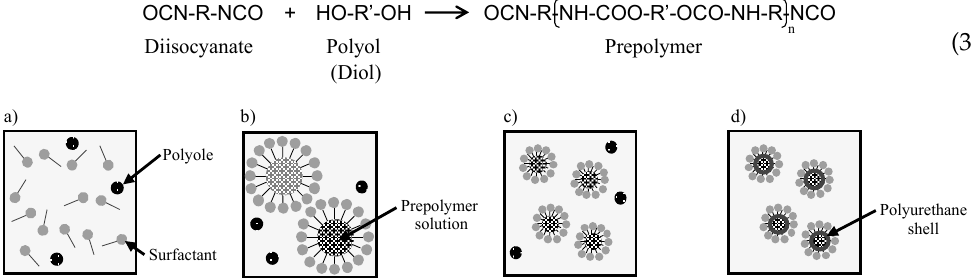
The synthesized prepolymer solution is dripped to the polyol and surfactant solu- tion. As the prepolymer solution hardly dissolves in the polyol and surfactant solution,